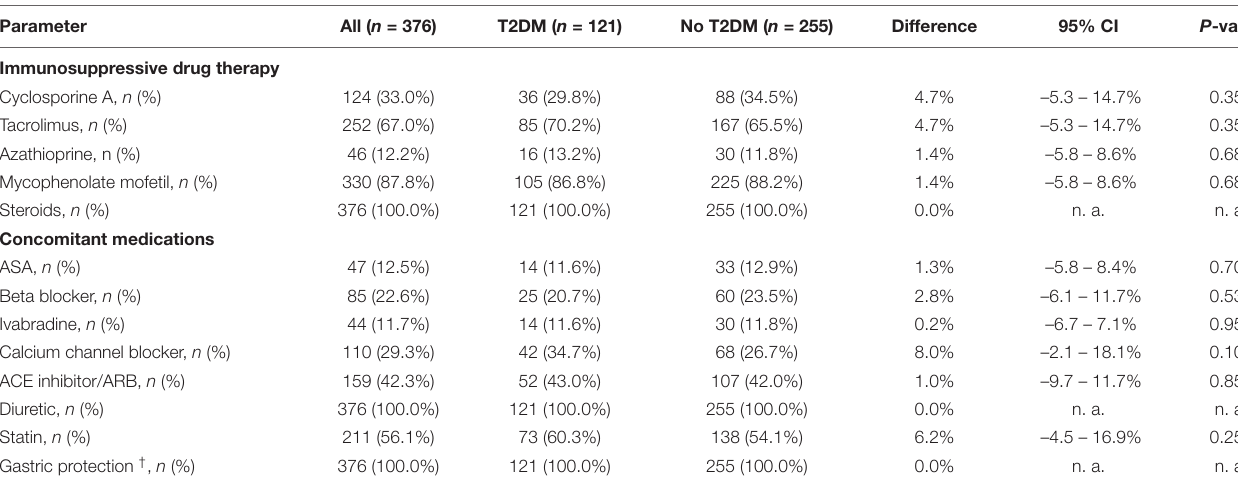
TABLE 3 | Medications after HTX – stratified by T2DM at